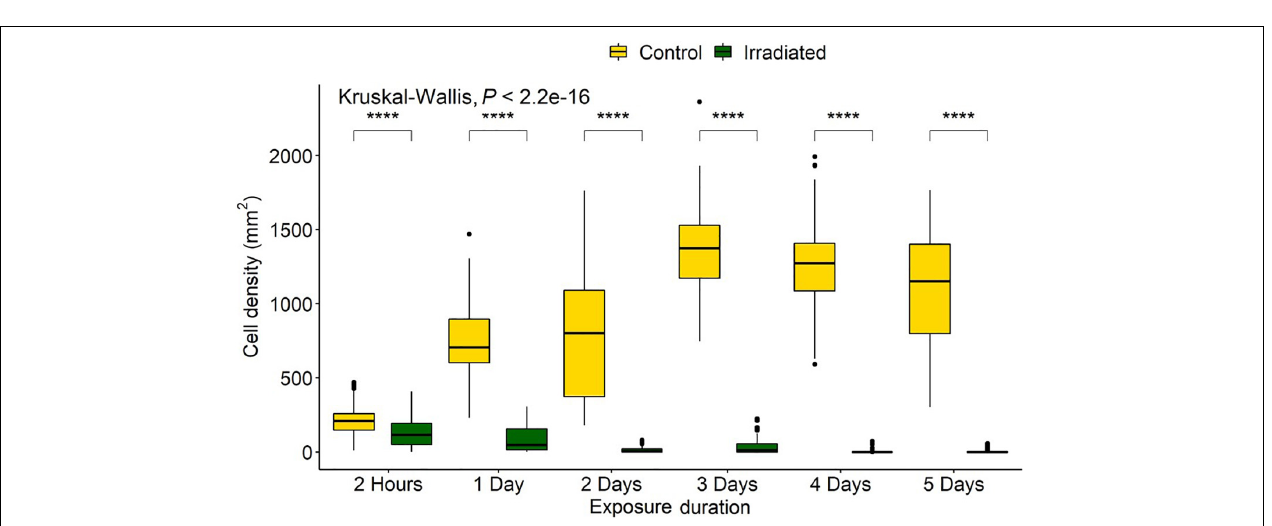
FIGURE 3 | Mean irradiances of eight LEDs embedded in two tiles (A,B) at varying voltages (18–24 V). These gave fluence values over 48 h of 0.01, 0.15, 0.82, 2.65, 6.23, 11.12, and 18.70 J/cm 2 , respectively.